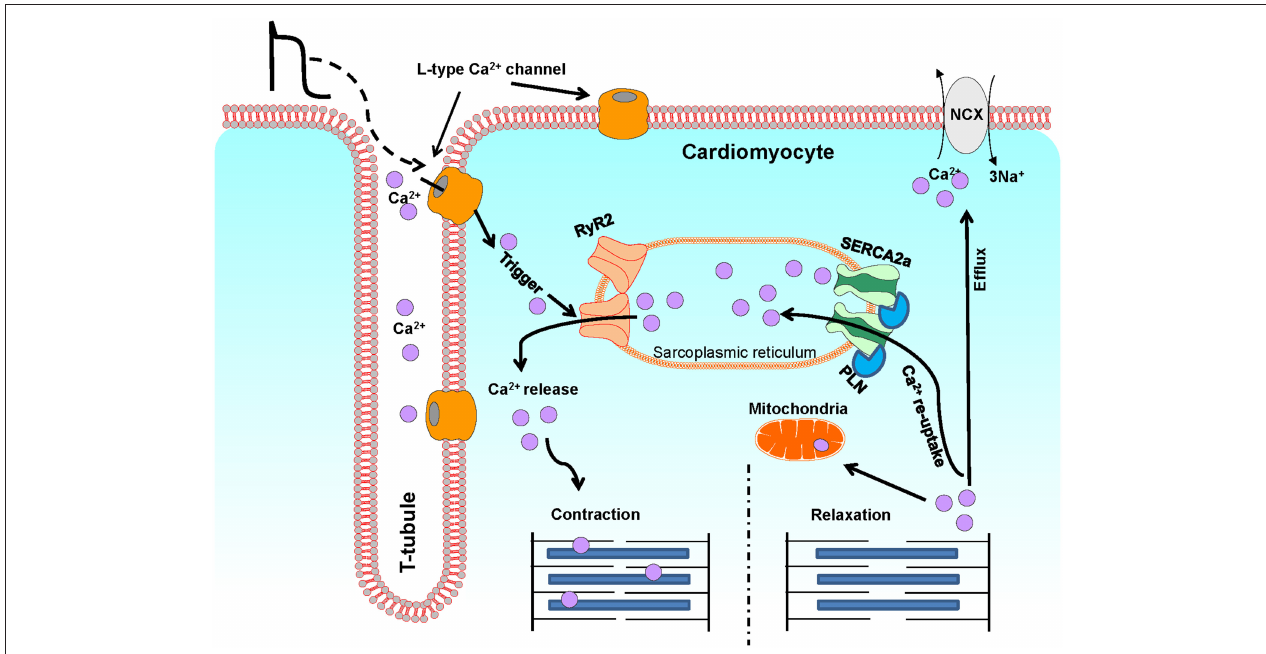
FIGURE 2 | A schematic illustration of Ca 2 + fluxes during excitation-contraction in ventricular cardiomyocytes. This diagram depicts the most representative protein complexes and intercellular organelles involved in the cardiac excitation-contraction coupling. Ca 2 + , calcium; SR, sarcoplasmic reticulum; M, Mitochondria; LTCC, L-type Ca 2 + channel; RyR2, Ryanodine receptor 2; SERCA2a, Sarcoplasmic reticulum Ca 2 + ATPase 2a; PLN, Phospholamban; NCX, Na + /Ca 2 + exchanger.